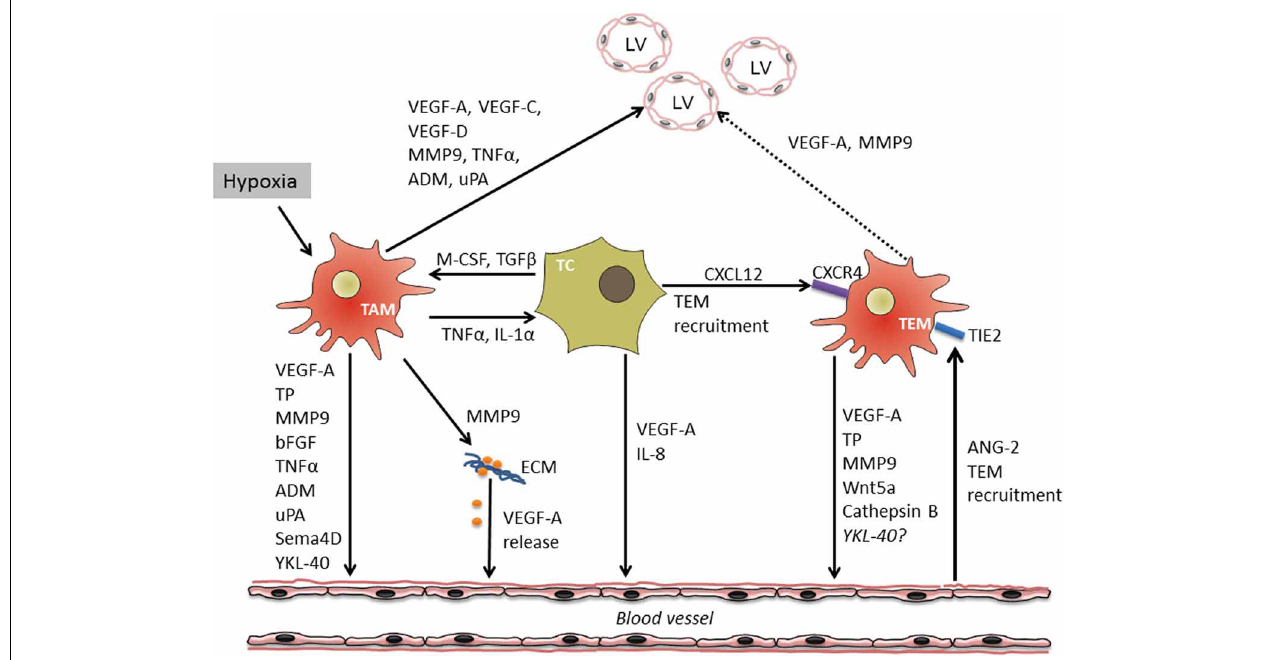
FIGURE 1 | Cross-talk between macrophages, tumor cells and endothelium during tumor angiogenesis and lymphangiogenesis. Tumor hypoxia and cytokine crosstalk between tumor cells (TC) and TAM results in the induction of a pro-angiogenic program in both cell types followed by the release of multiple soluble factors stimulating migration and proliferation of vascular endothelial cells (VEC) either directly or through the mobilization of